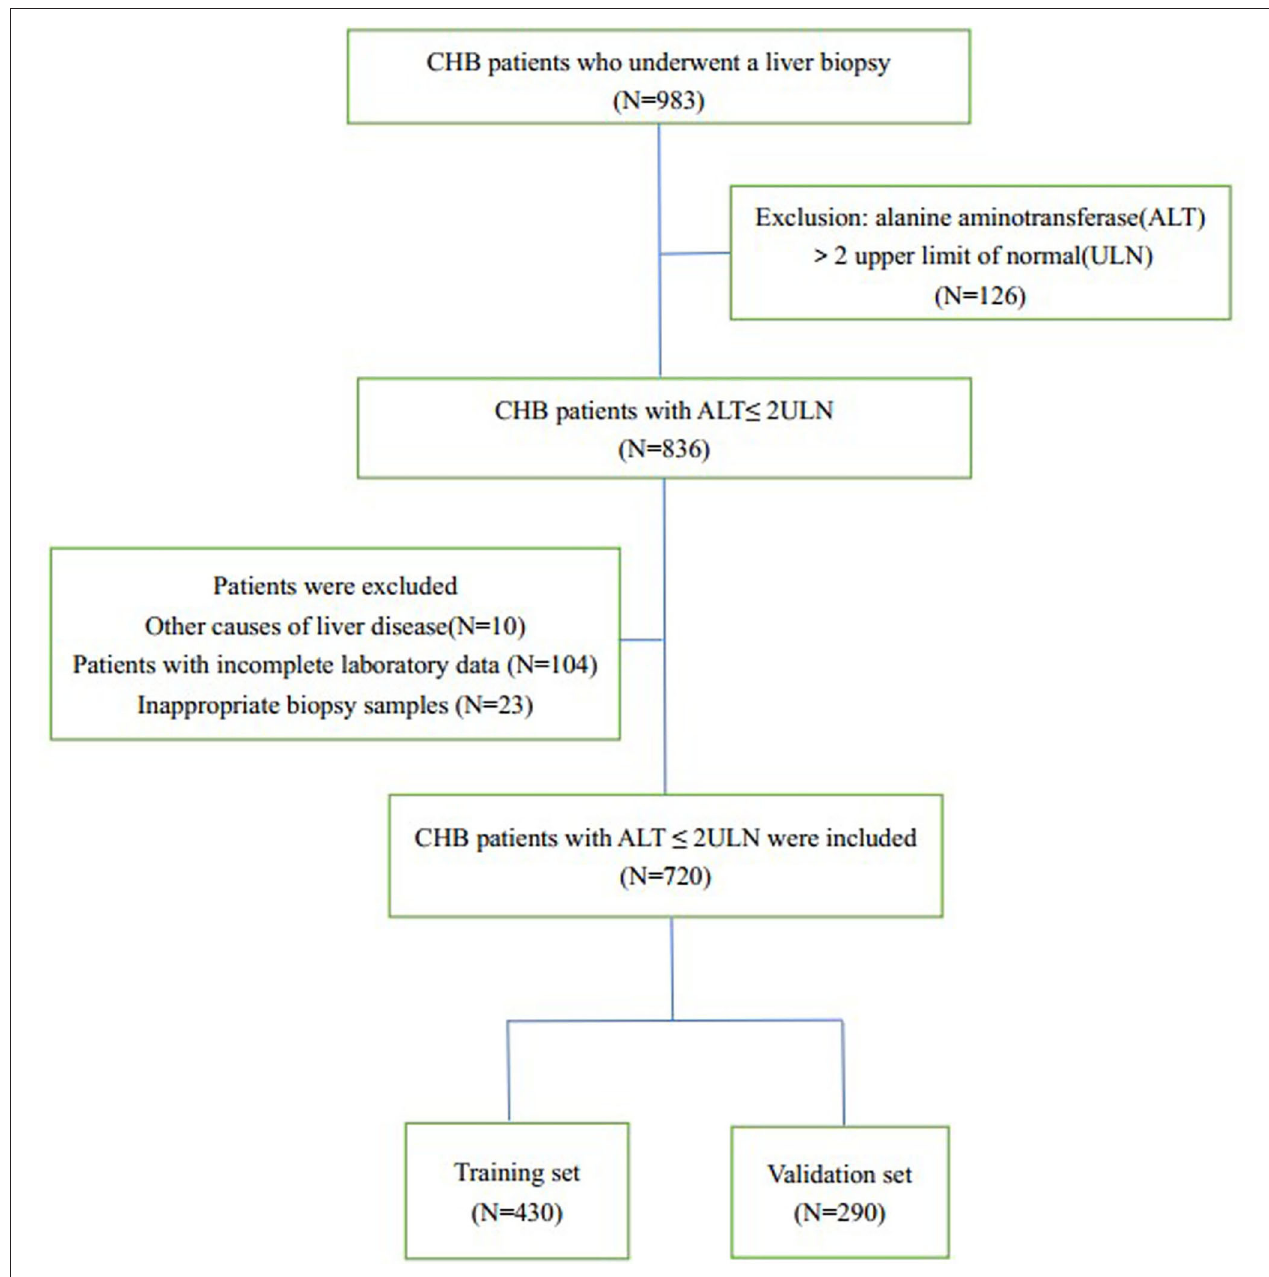
FIGURE 1 | Flow chart of the enrolment of patients. CHB, chronic hepatitis